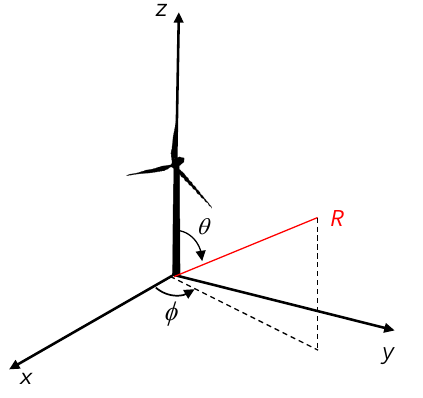
Figure 1. Spherical coordinate system used in the RCS calculations. R represents radar location.